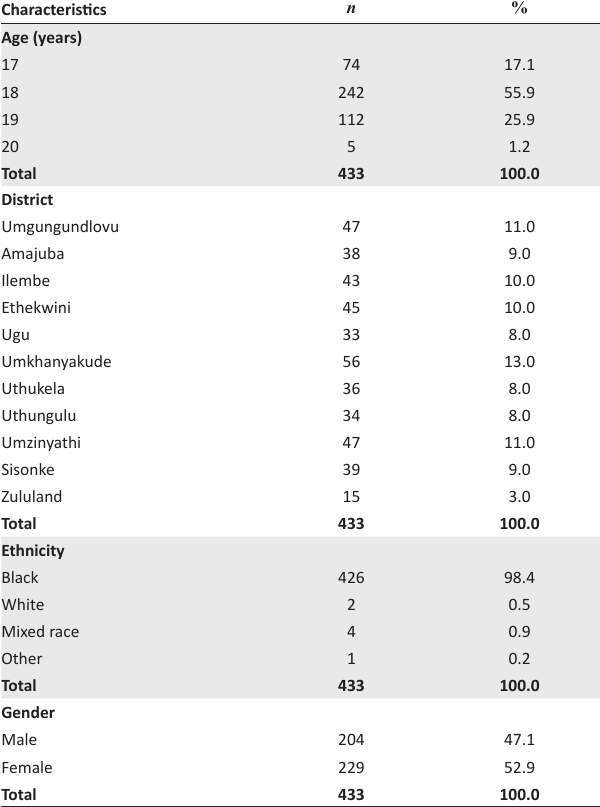
TABLE 2: Characteristics of the